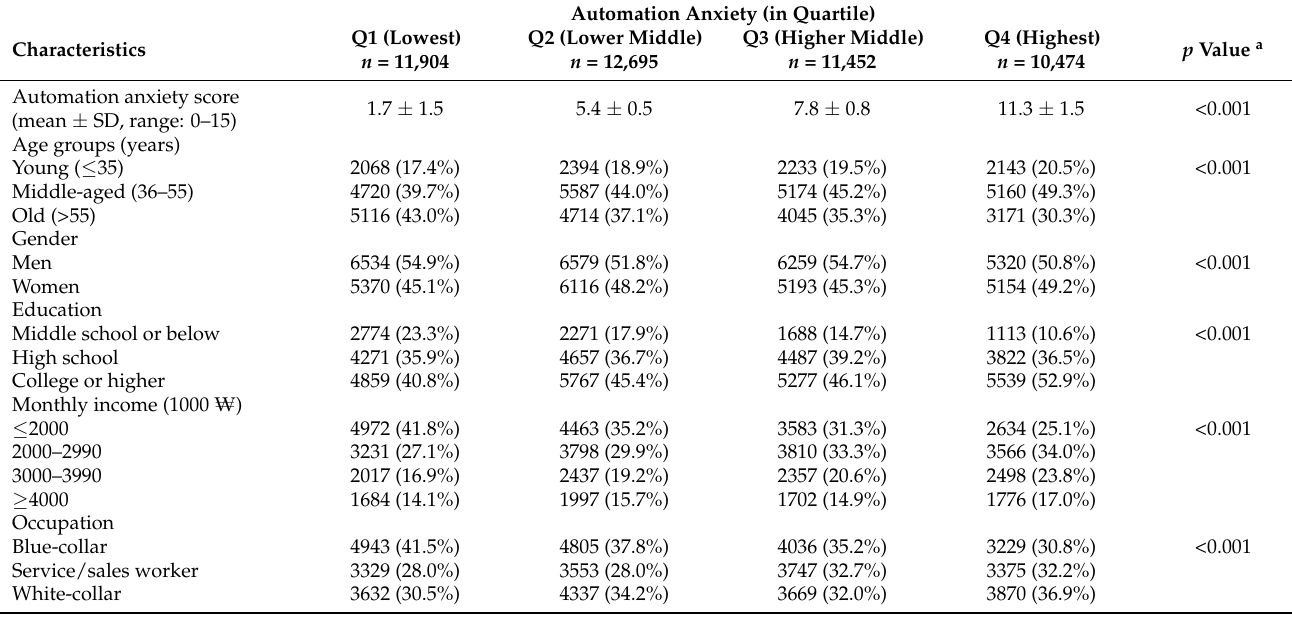
Table 2. Baseline characteristics and prevalence of sleep disturbance among study